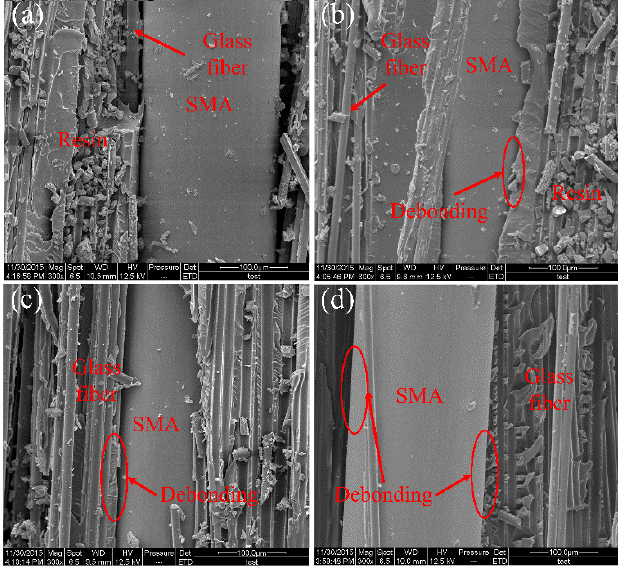
Figure 9. SEM micrograph of the fracture surface of (B-3) specimens. ( a ) B-3-2, ( b ) B-3-4, ( c ) B-3-6, ( d ) B-3-10. ( d )